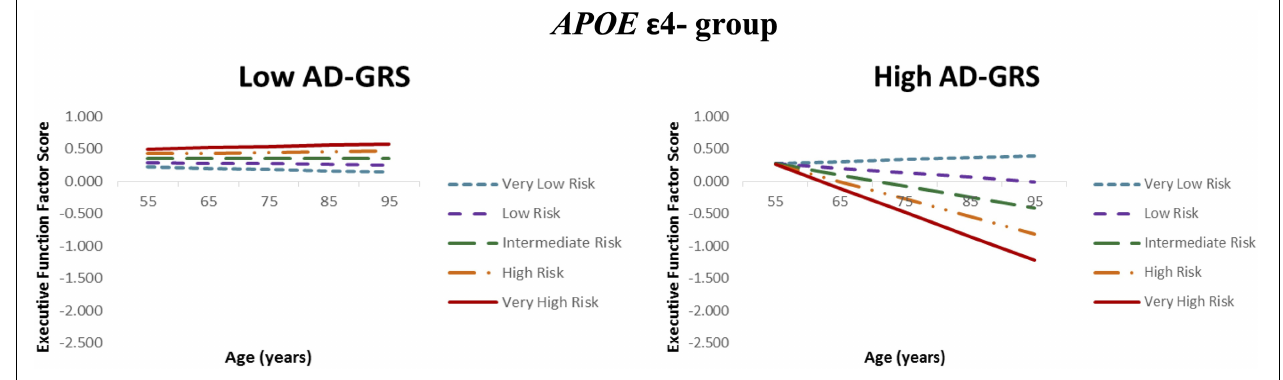
FIGURE 2 | Executive function trajectories for functional-health risk score as moderated by AD genetic risk. APOE ε 4 non-carriers with increasing functional-health risk scores had poorer EF performance and steeper 40-year trajectories selectively in the high AD-GRS group. Functional-health risk score is coded from very low risk (dashed blue line) to very high risk (solid red